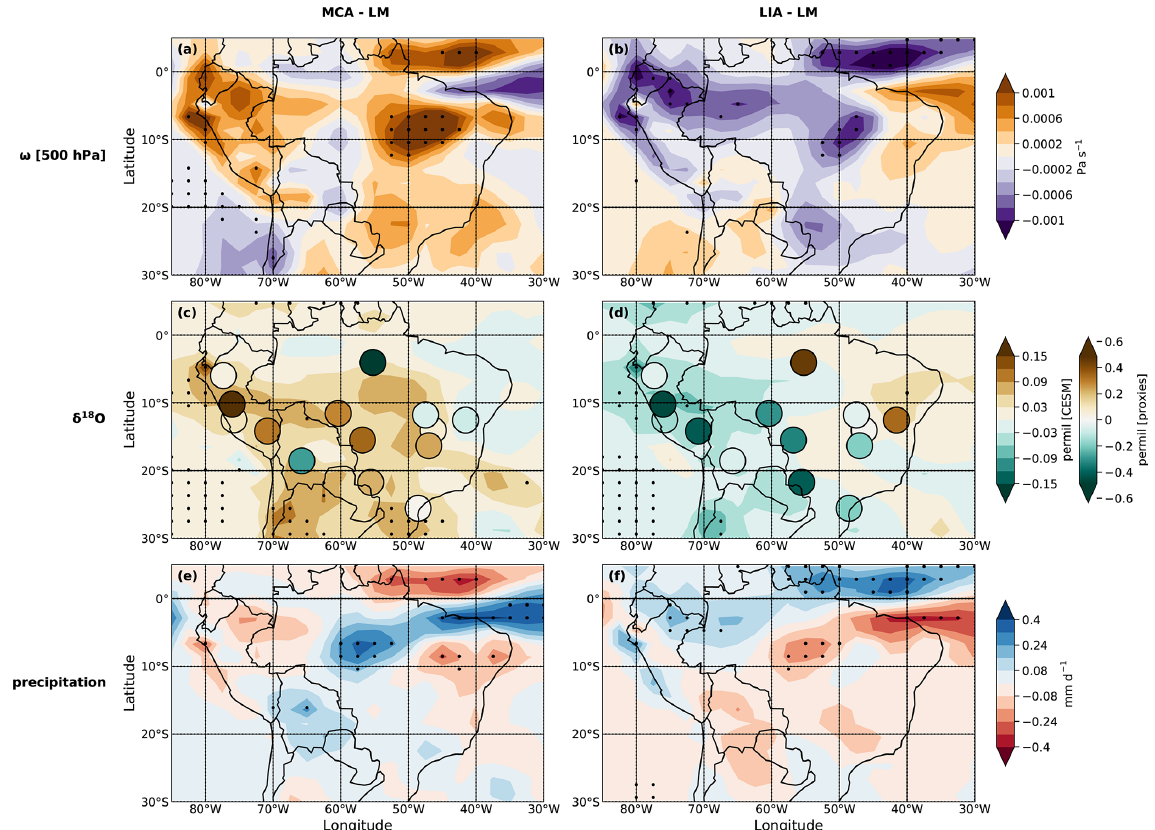
Figure 5. iCESM full-forcing multi-model mean anomalies during the MCA (850–1160CE; a, c, e ) and LIA (1489–1850CE; b, d, f ) relative to the full LM (850–1850CE) mean in austral summer (DJF) for (a, b) mid-tropospheric vertical velocity (500hPa, Pas − 1 ; note that negative anomalies signify enhanced upward motion and reduced subsidence), (c, d) precipitation-weighted δ 18 O (permil; colored circles represent values from proxy MC 1000-member ensemble mean; note that color scales differ between proxy and model estimates), and (e, f) precipitation (mmd − 1 ). Stippling indicates regions where anomalies are significant at p ≤ 0 .